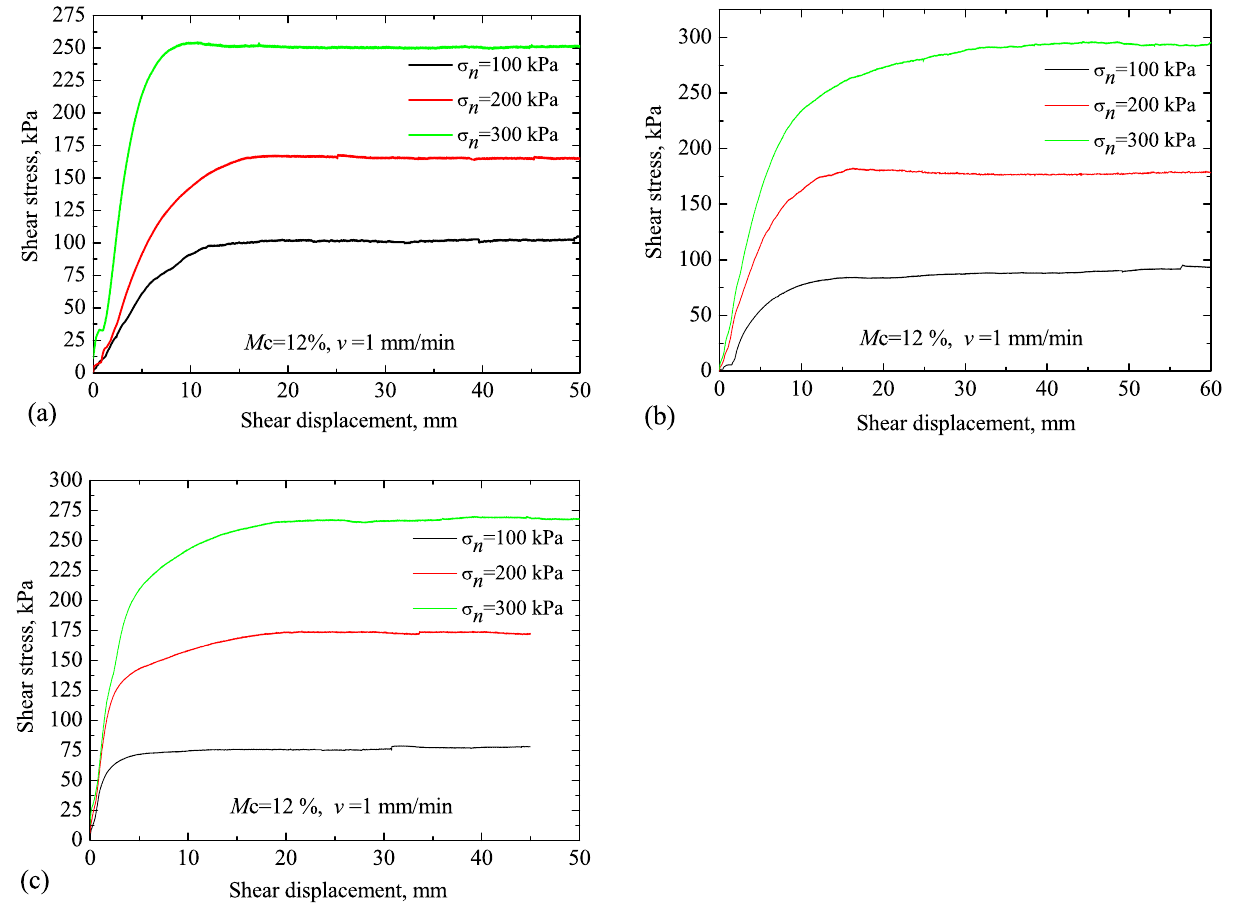
Figure 7. Stress–displacement curves under different normal stress. ( a ) Loess; ( b ) red clay; ( c )